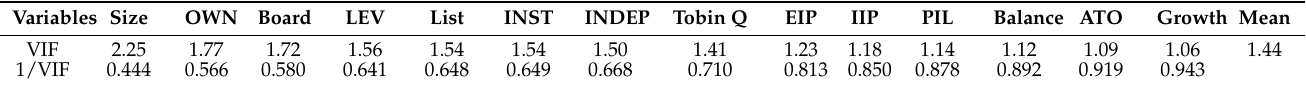
Table 5. Test of variance inflation factor.